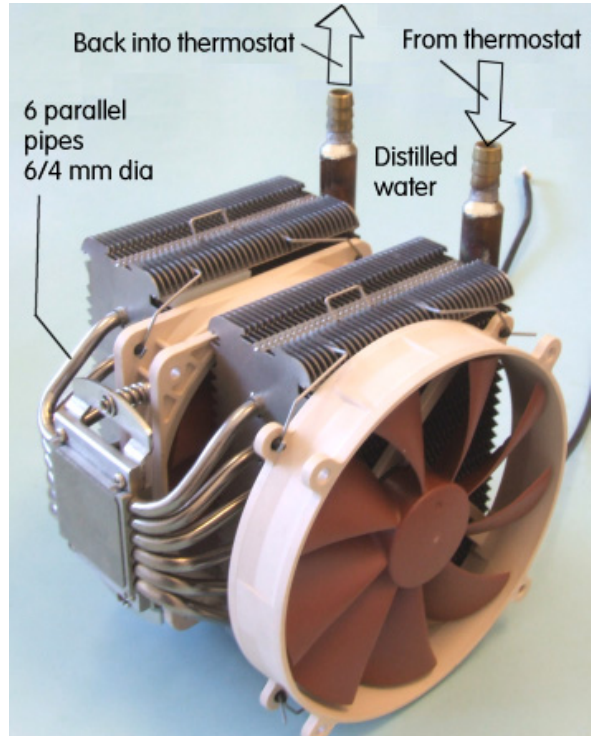
Fig. 19. Photograph of the heating and driving unit. Note the two series of the sheet-metal fins and the Ni coated copper pipes supplying them with heat from the thermostat.